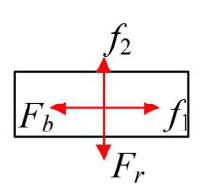
Figure 20. Force diagram of M.